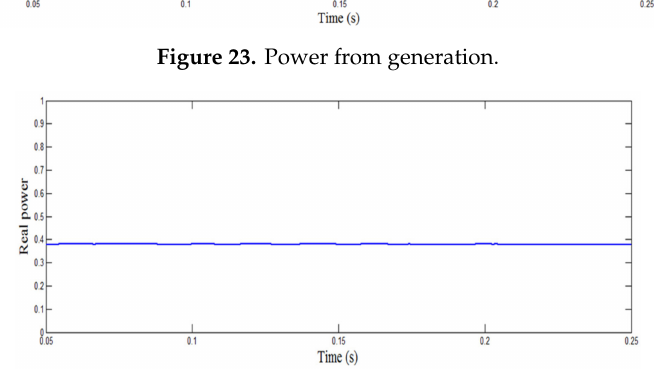
Figure 24. Real power demand from the load side.